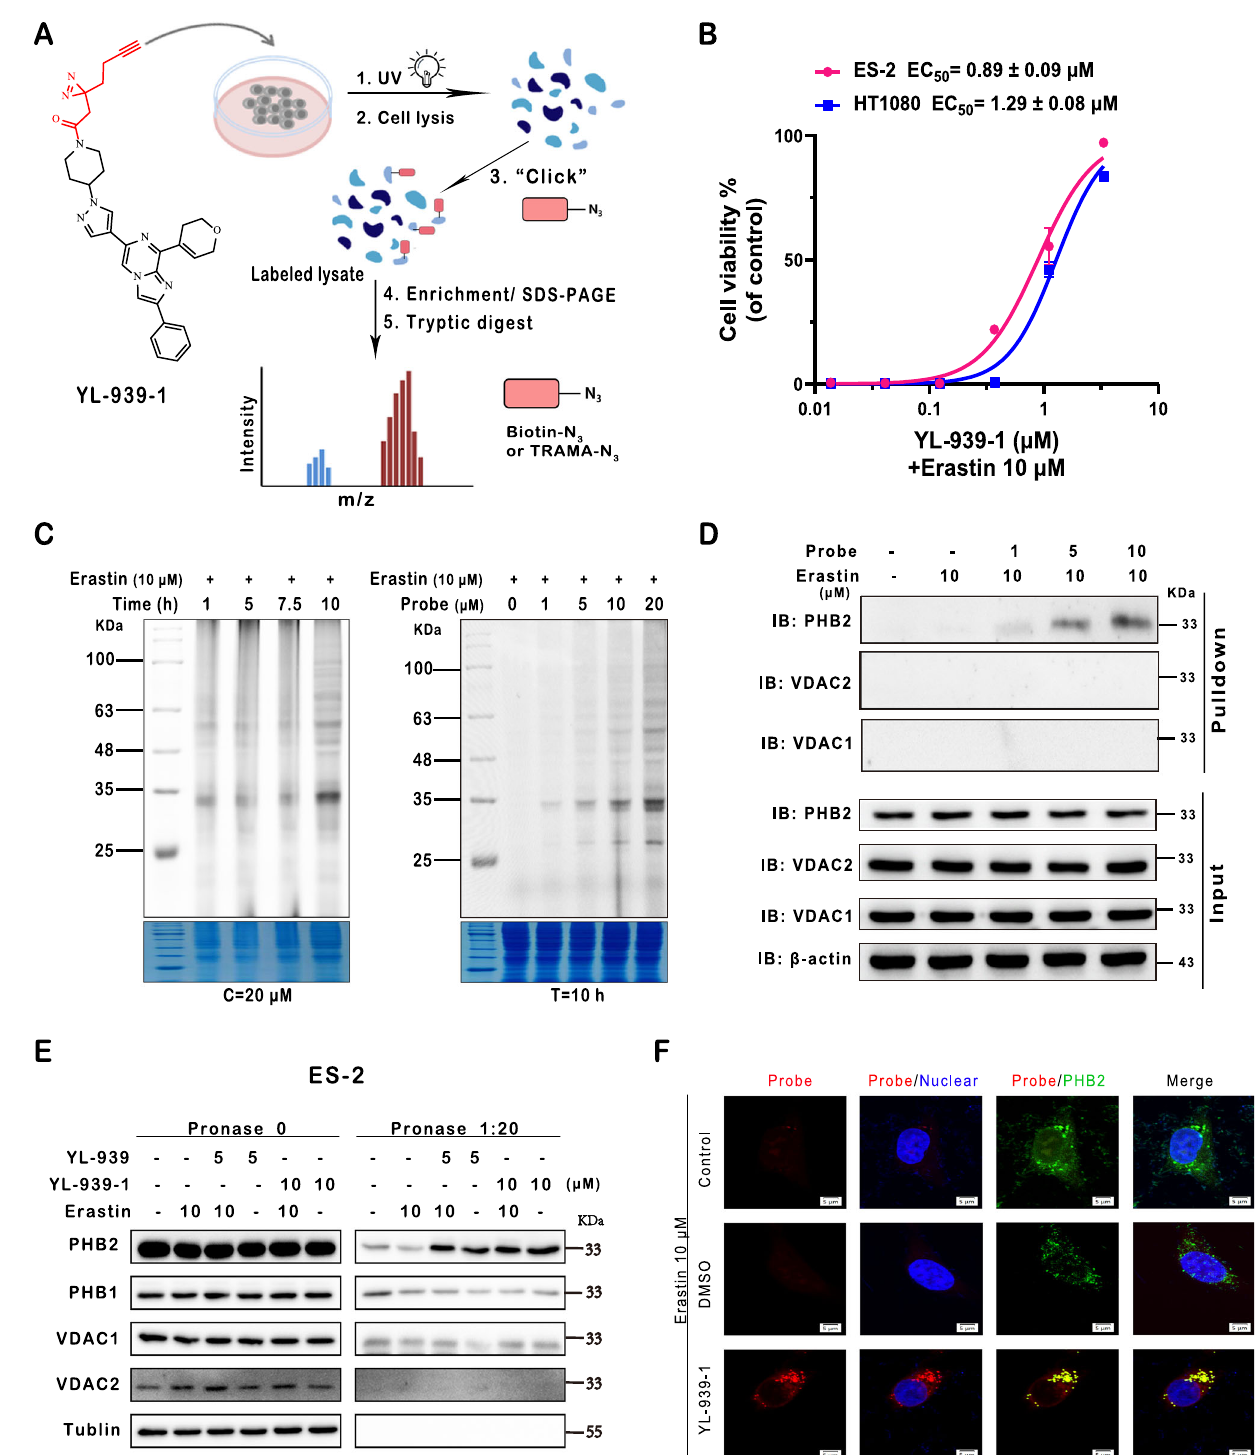
Fig. 4 | PHB2 was identi fi ed as the biological target of YL-939 in cells. A The chemical structure of YL-939-1 and the schematic process for the activity-based protein pro fi ling (ABPP) experiments. B Cell protection effects of YL-939-1 in erastin-inducedferroptosismodels(HT1080andES-2).Datarepresentmeanoftwo independent biological replicates. C Time- and concentration-dependent labeling pro fi lesofYL-939-1withES-2cells.Blotsshownarerepresentativeoftwobiological replicates. D Identi fi cation of YL-939-1 binding proteins using pull-down/western